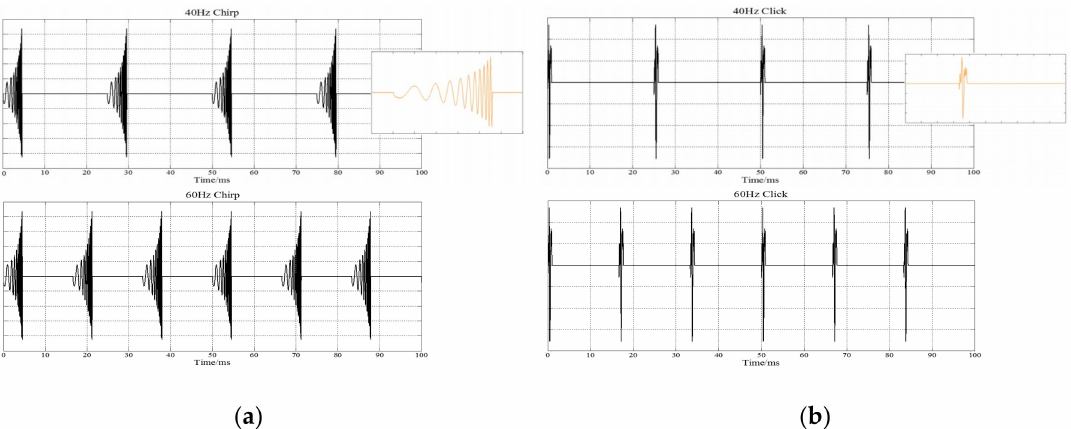
Figure 1. The schematic representation of the click and chirp stimuli: ( a ) the waveform of the chirp stimuli; ( b ) the waveform of the click stimuli. 40 Hz stimuli waveform at the top and 60 Hz stimuli waveform at the bottom in each subgraph.